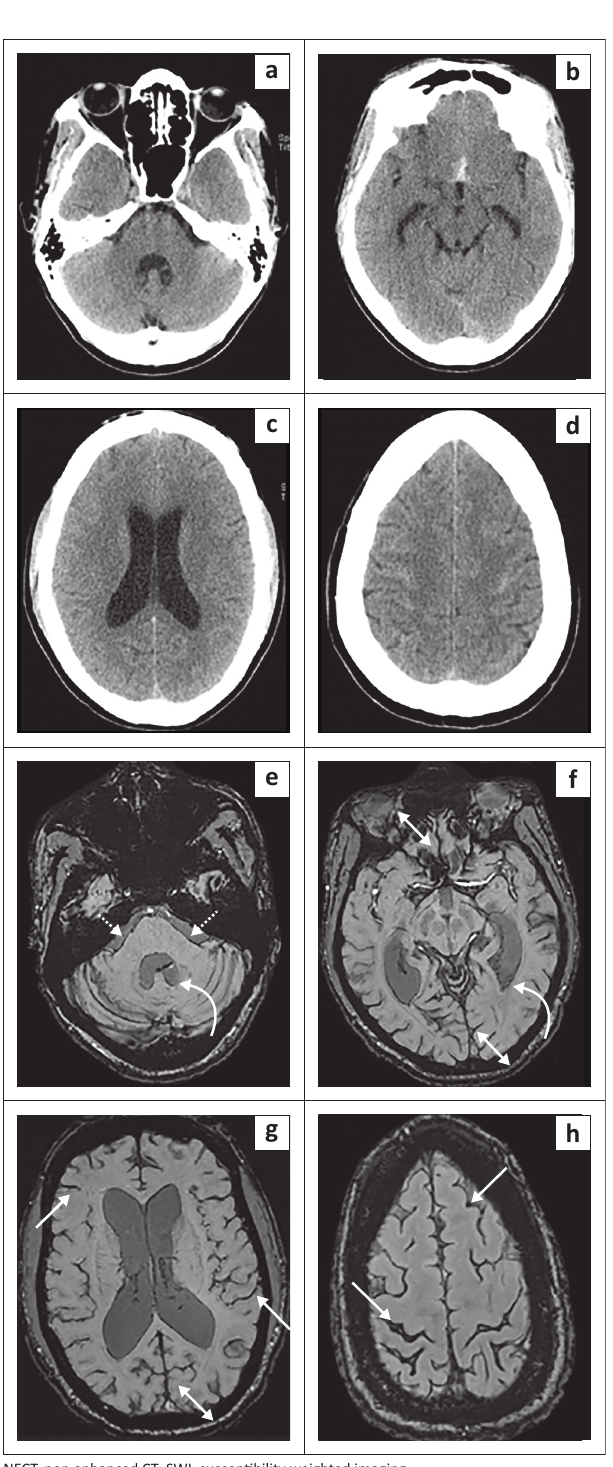
NECT, non enhanced CT; SWI, susceptibility weighted imaging. FIGURE 2: The NECT at presentation (a–d) and SWI at 3 months (e–h) in a patient with a ruptured anterior communicating aneurysm. The NECT demonstrates localised haematoma within the lamina terminalis (a) and frontoparietal convexities (d). The SWI at 3 months demonstrates diffuse blooming (haemosiderin) remote to the initial haemorrhagic load now along the cerebral convexities (white arrows), interhemispheric fissure (double white arrows), intraventricular (curved white arrow) and posterior cranial fossa cisterns (dashed white arrows) (e). dependent regions of the ventricular system (occipital horns of the lateral ventricles and dependent lateral recesses of the 4th ventricle).